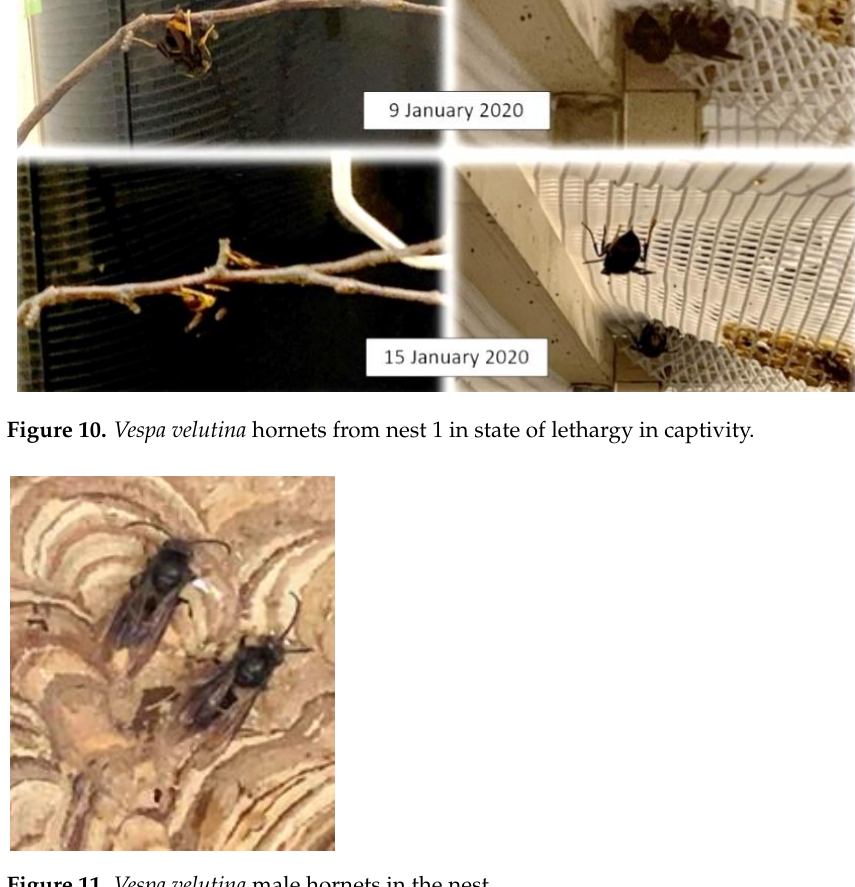
Figure 10. Vespa velutina hornets from nest 1 in state of lethargy in captivity.